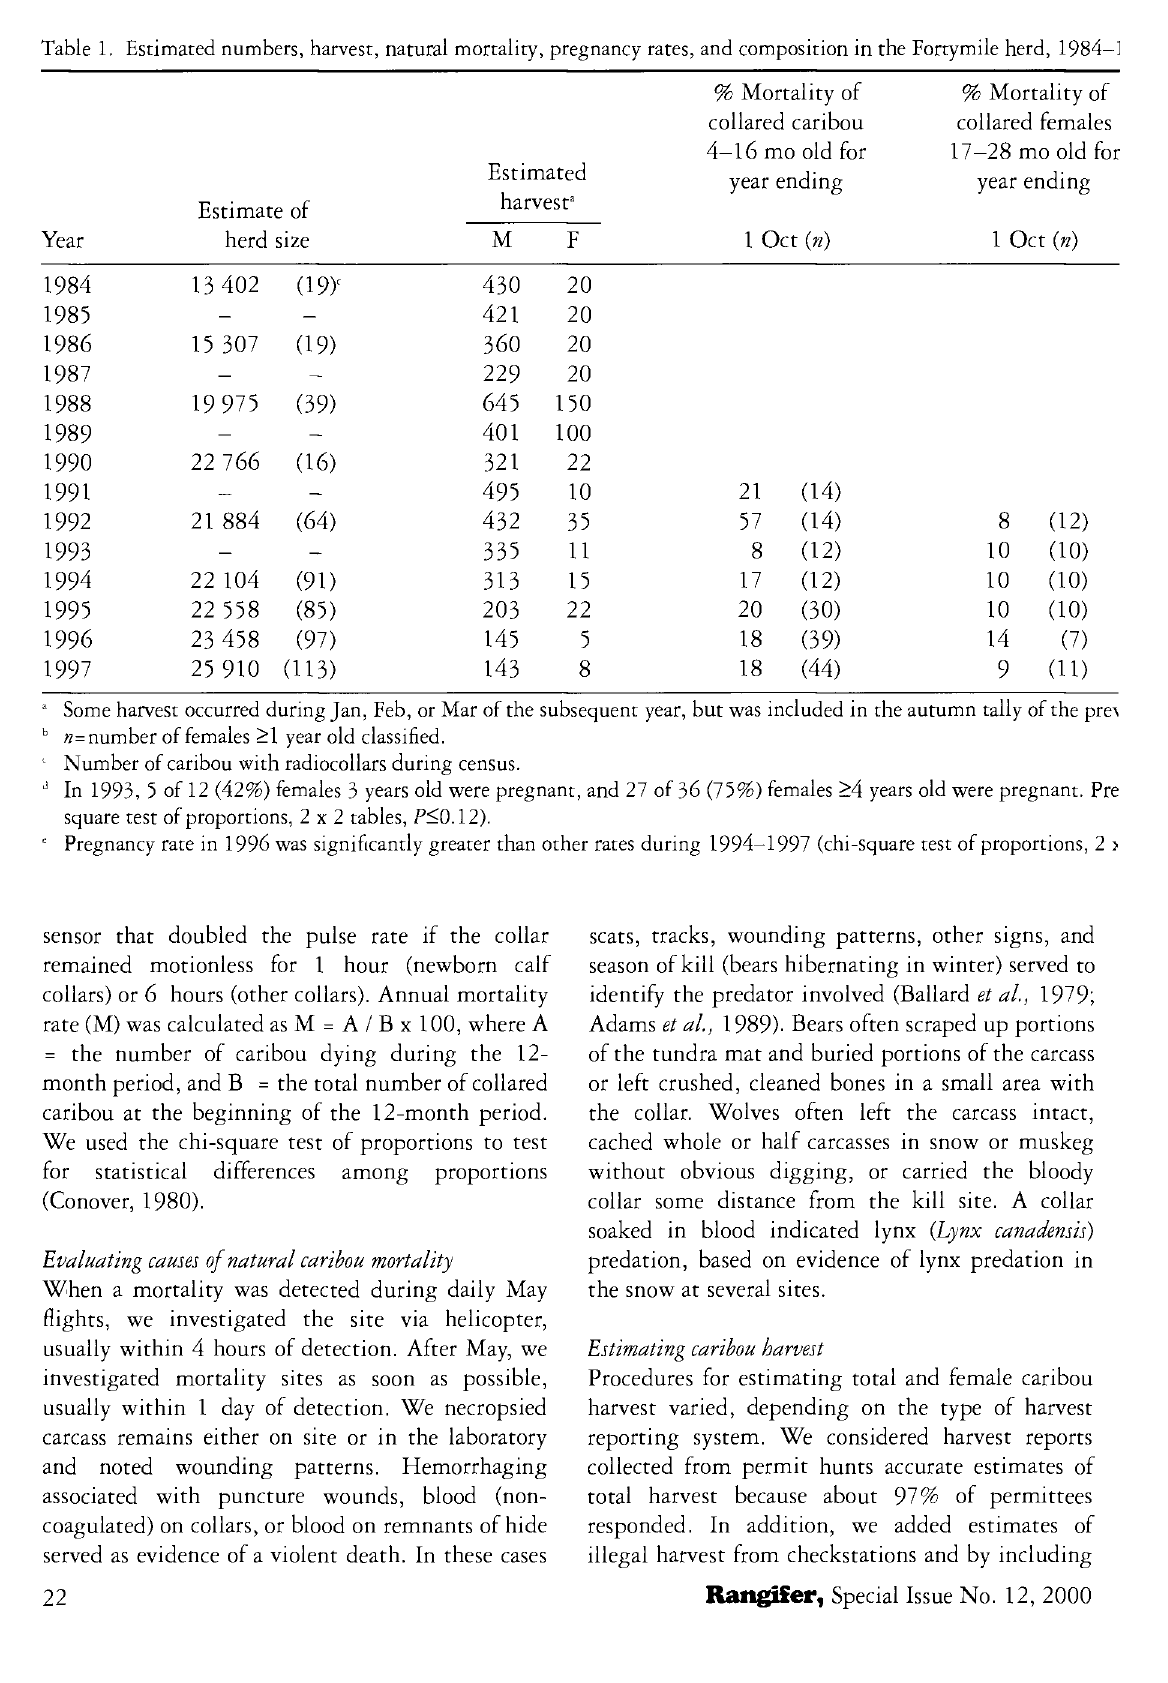
Table 1. Estimated numbers, harvest, natural mortality, pregnancy rates, and composition in the Fortymile herd, 1984—]